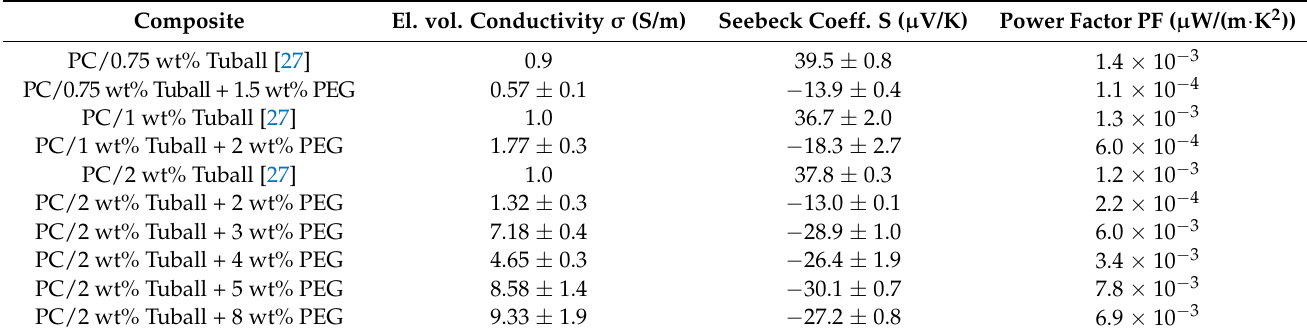
Table 2. TE properties of PC composites with SWCNT Tuball and PEG in different